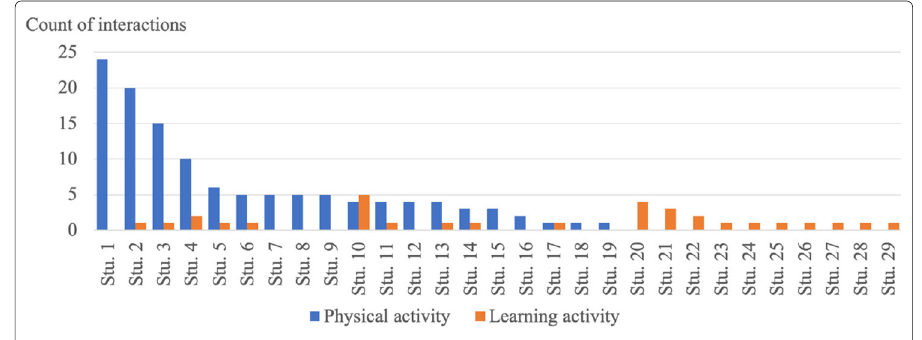
Fig. 8 Interaction count of analysis behavior in learning and physical